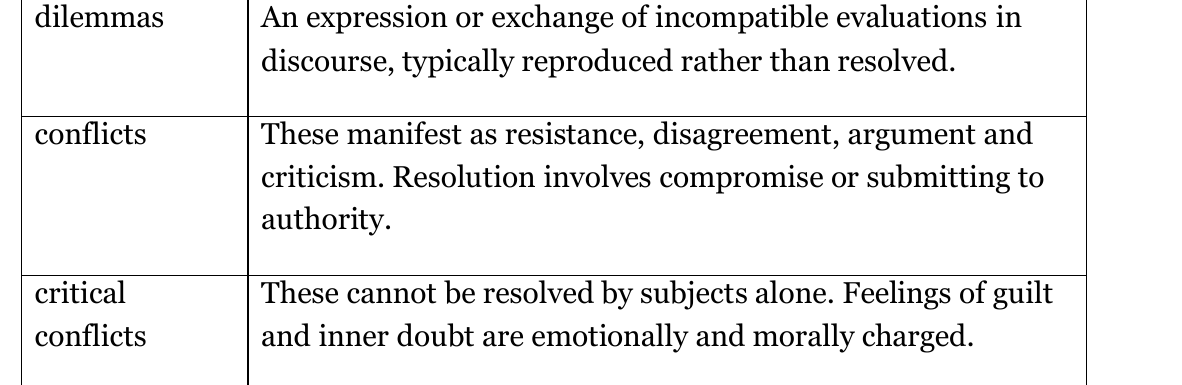
Table 2: discursive manifestations